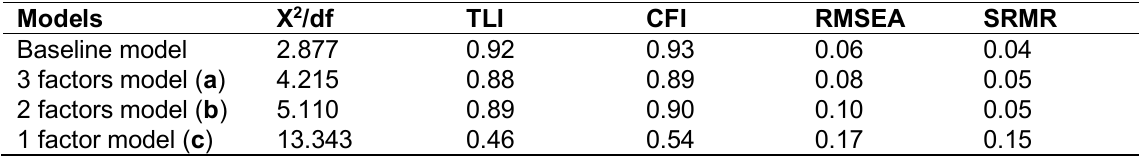
Table 5: CFA results, Comparison of measurement